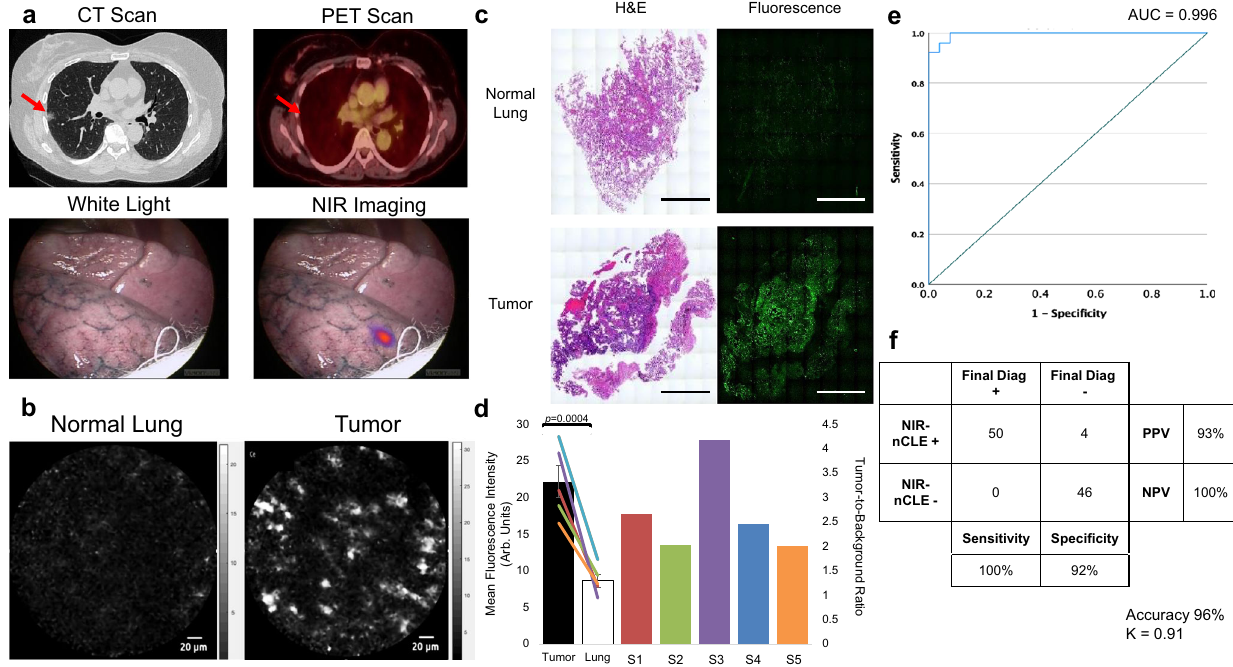
Fig. 5 NIR-nCLE can discriminate tumor from normal lung in sub-solid human tumors. a Preoperative and intraoperative imaging from a representative patient with a small ground glass opacity (GGO, marked by red arrow) that was preoperatively infused with pafolacianine. The lesion is not identi fi able by white light imaging but is clearly labeled on NIR imaging. b NIR-nCLE images of normal lung and tumor taken on ex vivo specimens. c H&E and fl uorescence microscopy of biopsy specimens taken at the site of NIR-nCLE imaging. Scale bars represent 5 mm. d Fluorescence analysis of NIR-nCLE sequences. Black and white bars represent the MFI of tumor and normal lung biopsy sequences, respectively, averaged across all biopsy specimens ( n = 10 tumor biopsies from biologically independent samples and n = 10 normal lung biopsies from biologically independent samples). Data are presented as mean values ± SEM. Colored lines represent the MFI of tumor and normal lung for individual study participants. The colored bars represent the tumor-to-background ratios of individual subjects and colors correspond to those of lines depicting MFI. Statistical comparisons were performed using two-sided t tests and p values are shown on the graph. e Receiver operating characteristic (ROC) analysis showed that high area under the curve (AUC) was obtained for MFI (AUC = 0.996, 95% CI: 0.986 – 1.000). f Diagnostic performance of NIR-nCLE sequences when analyzed by 5 non-expert raters, blinded to the fi nal histopathologic diagnosis associated with each